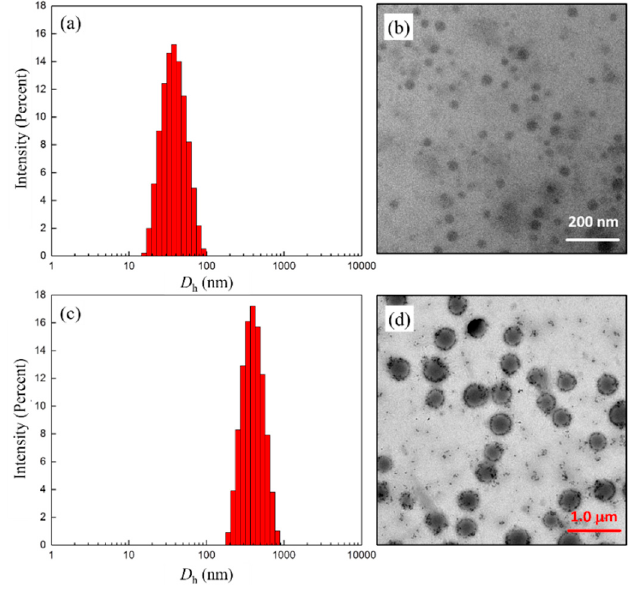
Figure 3. DLS results and TEM images obtained from aqueous solutions of copolymers 7c ( a , b ) and 7f ( c , d ), respectively. Sample conc. = 1 mg/mL.